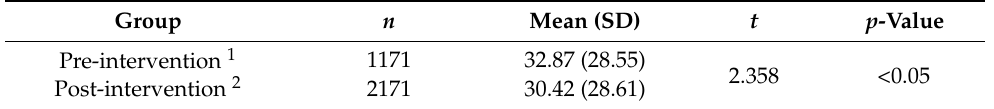
Figure A1. Kernel density curve of the time required to order TPN by ward physicians during pre- and post-intervention periods. TPN, total parenteral nutrition. Table A3. Student’s t -test results of the length of hospital stay (days) in non-critically ill adult inpatients receiving NST services during the pre- and post-intervention periods.